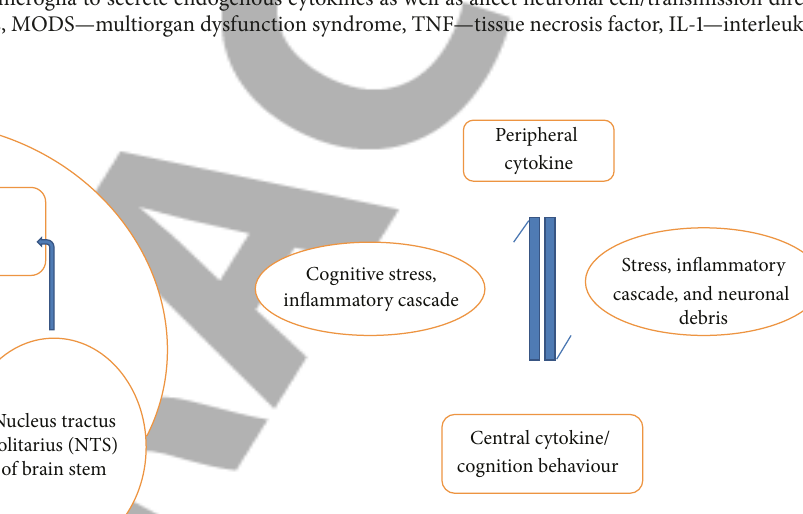
Figure 3: Two-way communication of peripheral and central cytokines (peripheral cytokines affect central cytokines, whereas central stress behaviour affects the peripheral cytokines